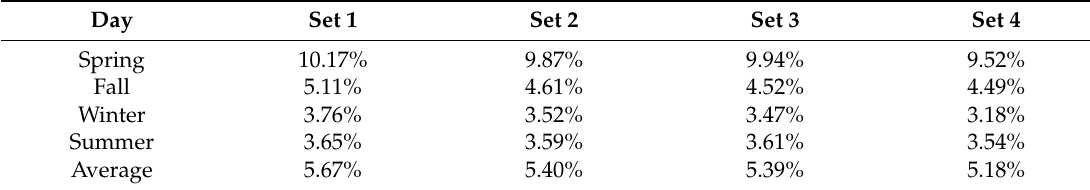
Table 7. Input Data Dependency Results—Stage